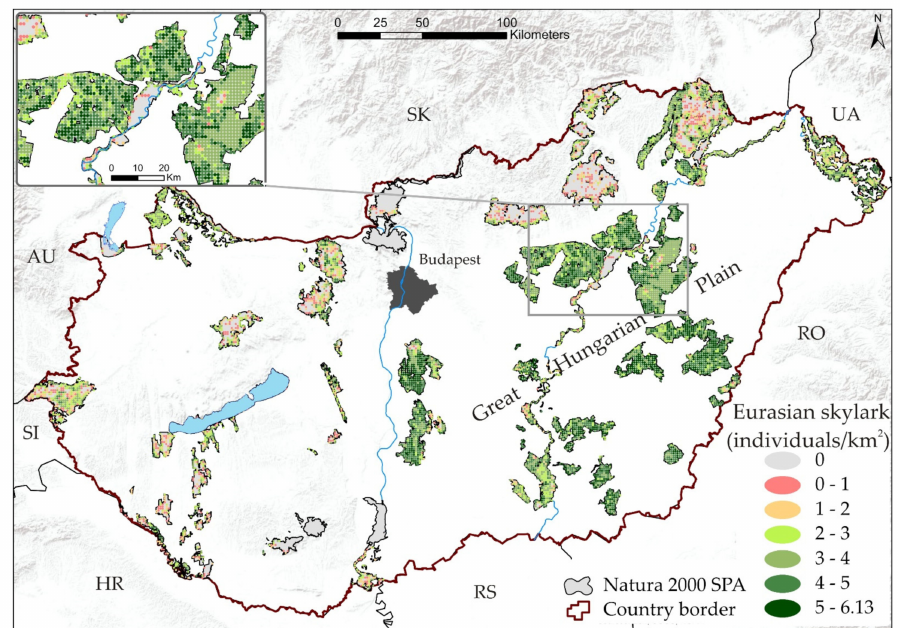
Figure 5. Predicted Eurasian skylark population (individuals/km*) in the 600 m buffer zones inside the Natura 2000 SPA